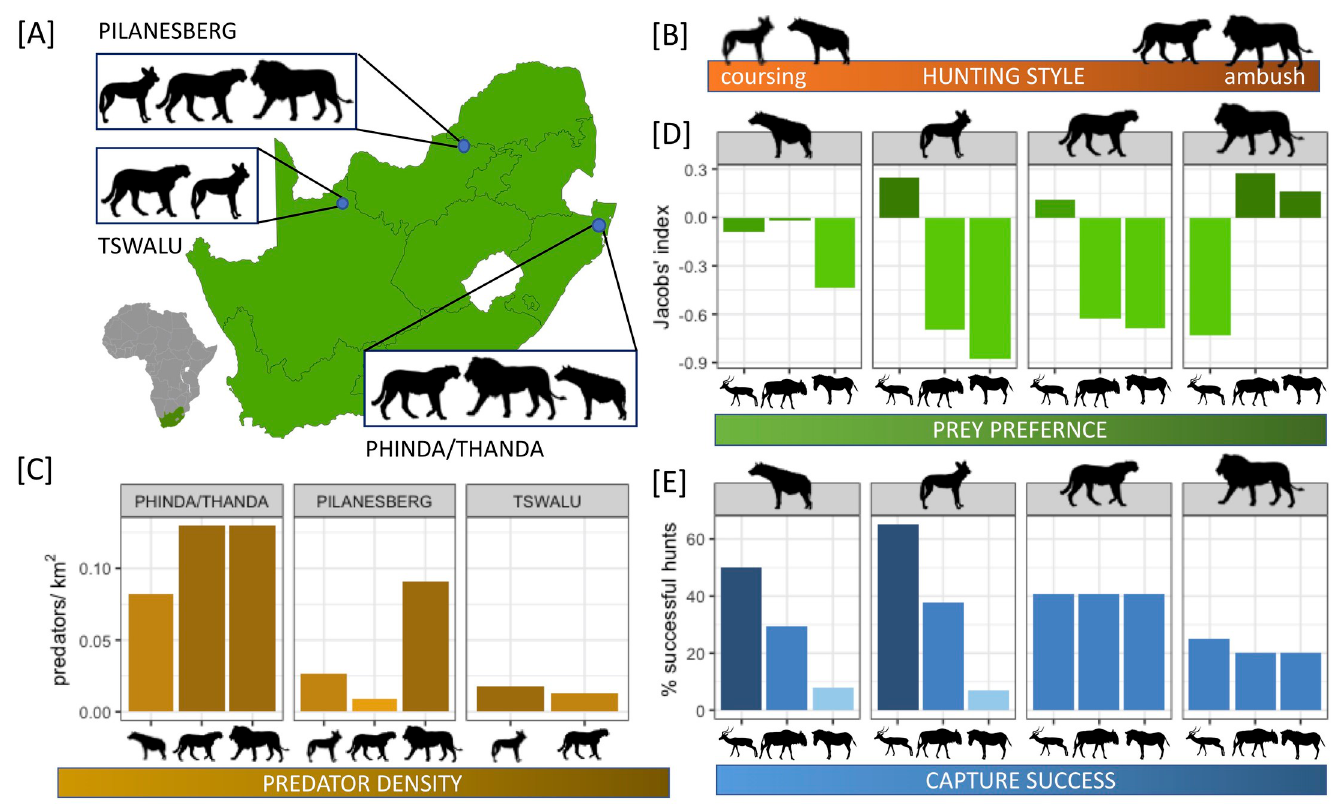
Fig 1. [A] Map of study sites with [B-E] characteristics of spotted hyenas, wild dogs, cheetahs, and lions which may influence prey’s choice of anti-predator behavioral response. [B] Hunting style , dichotomized as coursing or ambush; [C] Predator density , in predators/km 2 ; [D] Prey preference , the degree to which predators select for each individual prey species, represented by a Jacobs’ preference index which ranges from -1 (strong avoidance) to +1 (strong preference); [E] Capture success , the proportion of initiated hunts that end in a kill for each prey species. See text for references.